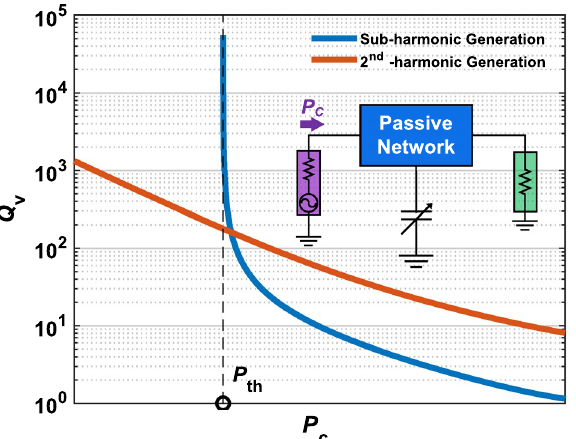
Figure 2. The power dependent quality factor exhibited by an ideal largely modulated reactance used for frequency division or frequency doubling. Typical trends of Q v versus P c attained through circuit simulations and relative to an ideal nonlinear reactance, independently used by two same-order and same-topology passive circuits respectively optimized for frequency division by two (in blue) or for frequency doubling (in red). More details about the simulation strategy we followed to extract these trends are reported in Supplementary Fig.